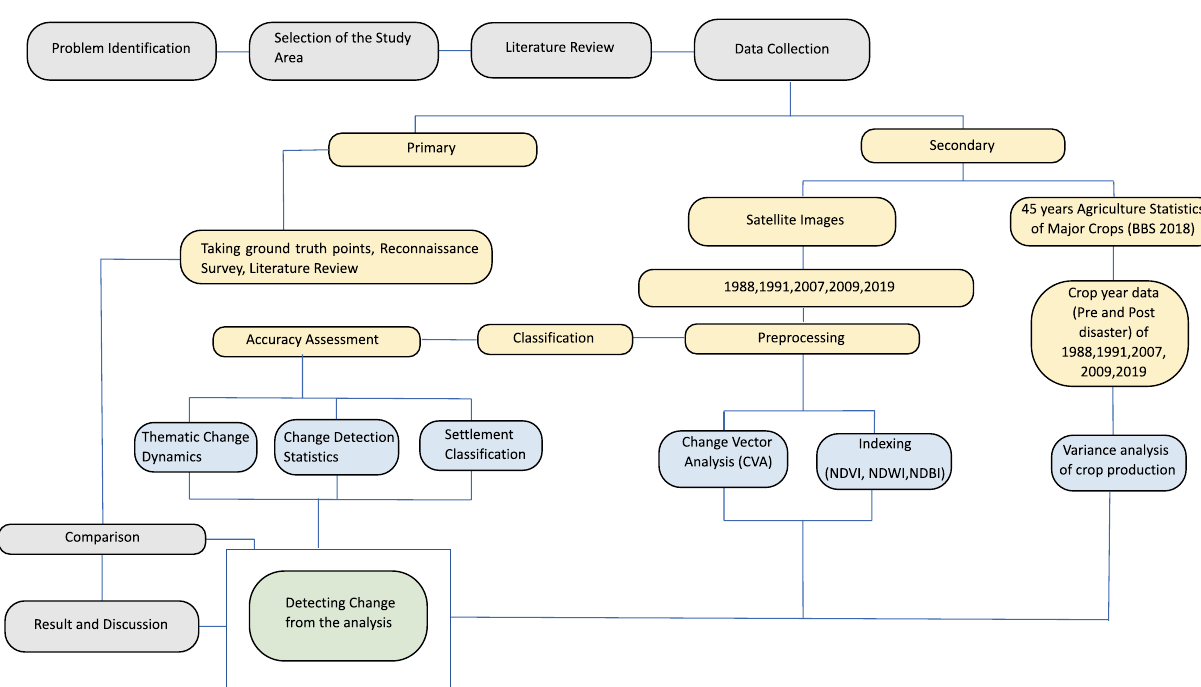
Fig. 2 Overall methodological